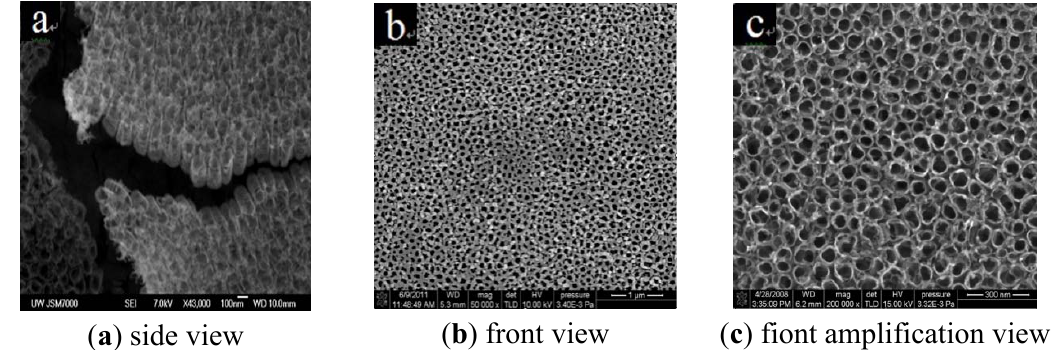
nanotube array. 2